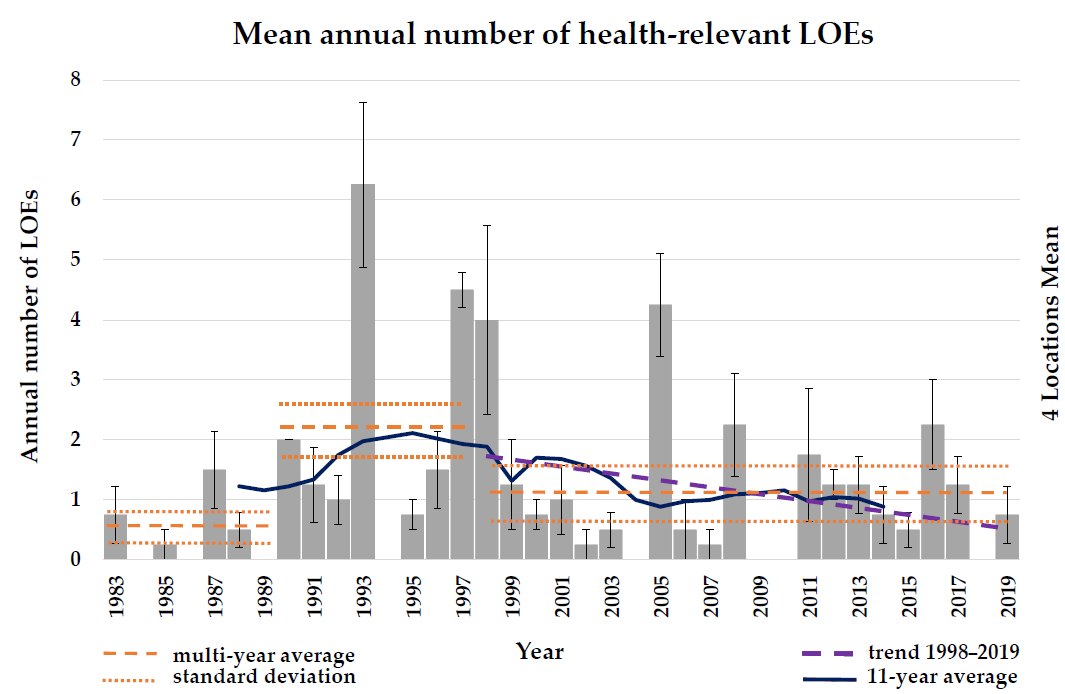
Figure 4. Mean annual number of health-relevant LOEs in Germany in the period 1983–2019 to- gether with the 11-year moving average (blue line), the linear trend of the subperiod 1998–2019 (purple dashed line) and the averages and standard deviations of the subperiods T1 (1983–1989), T2 (1990–1997), T3 (1998–2019) (orange dashed lines) (grey: 4-location means and standard deviations).